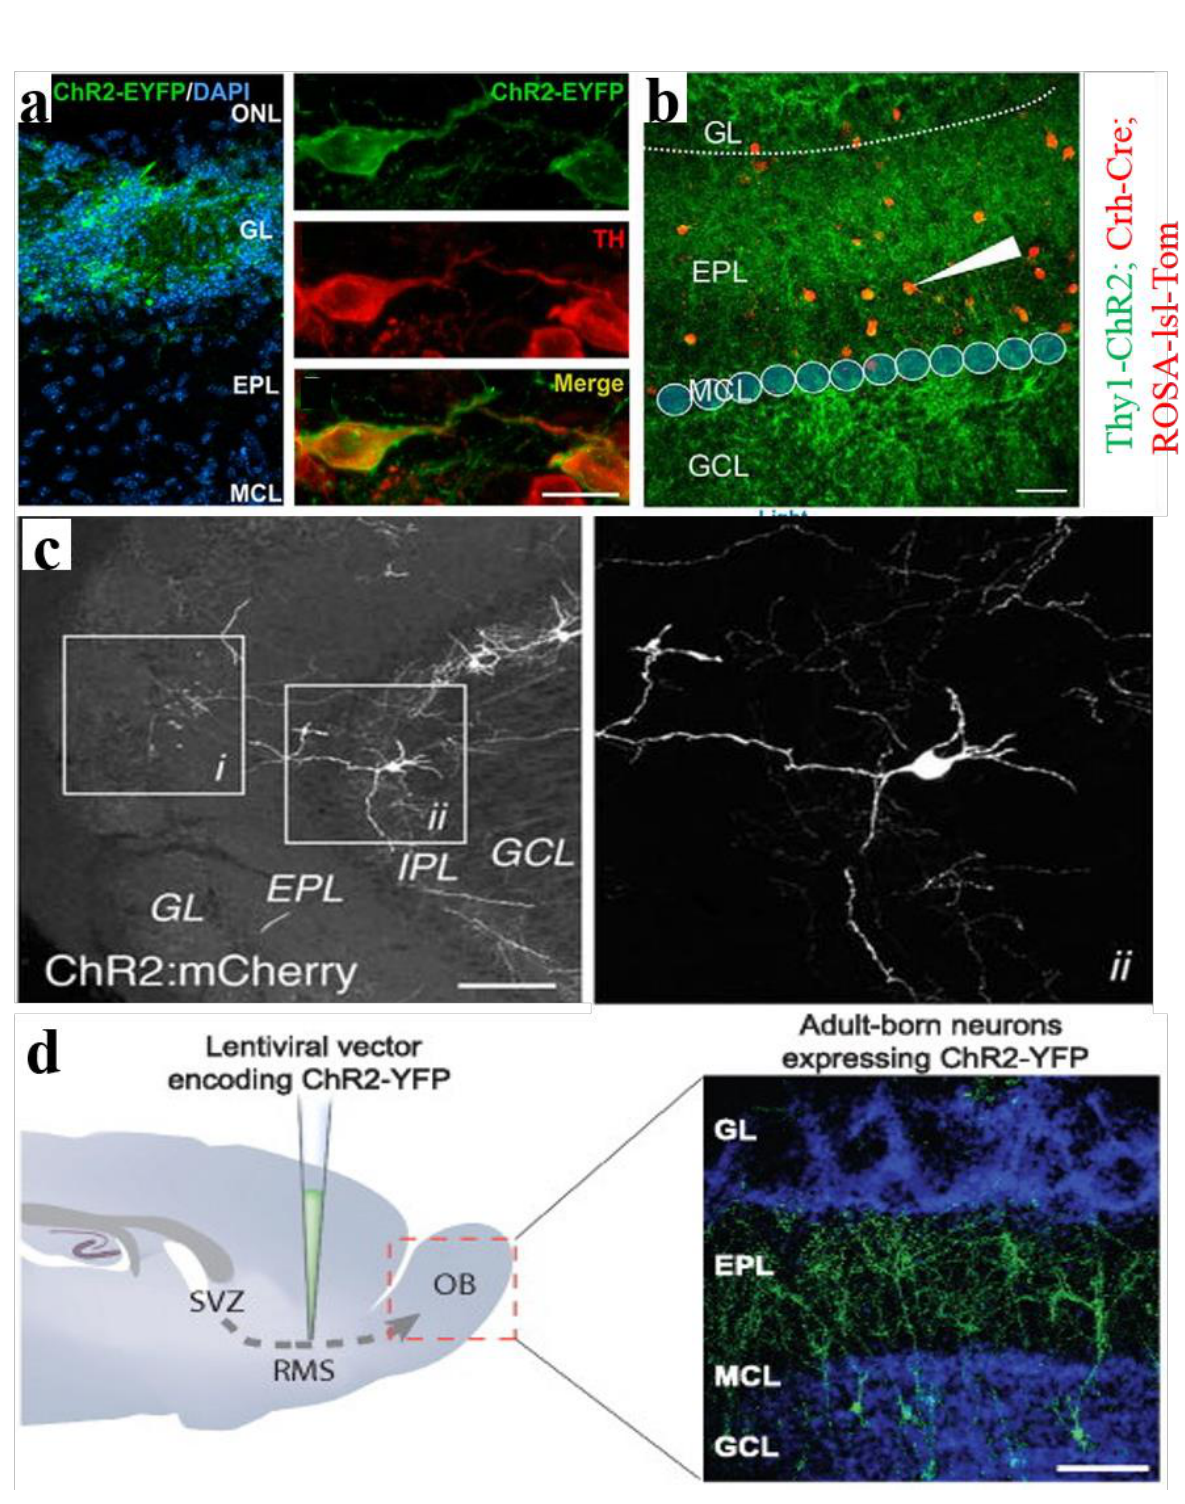
Figure 4. Cell-type-selective investigation of MOB inhibitory circuits. ( a ) The selective expression of ChR2-EYFP in the GL and brief optical stimulation of SACs inhibits MTC firing [39] . ( b ) Diagram of the MC-to-EPL interneuron connectivity mapping [40] . ( c ) ChR2:mCherry expression in the IPL and representative cell-attached recording of a GL-dSAC after brief photostimulation [35]. ( d ) The immunoreactivity of ChR2-YFP in adult-born neurons (green) and DAPI staining in all cell nuclei (blue), which can be activated by flashes of blue light ( ∼ 470 nm) [92]. Reproduced with permission from ( a ) [42], Copyright 2016 Society for Neuroscience; ( b ) [43], Copyright 2016 Society for Neuroscience; ( c ) [37], Copyright 2016 Society for Neuroscience; ( d ) [92], Copyright 2010 Society for Neuroscience.